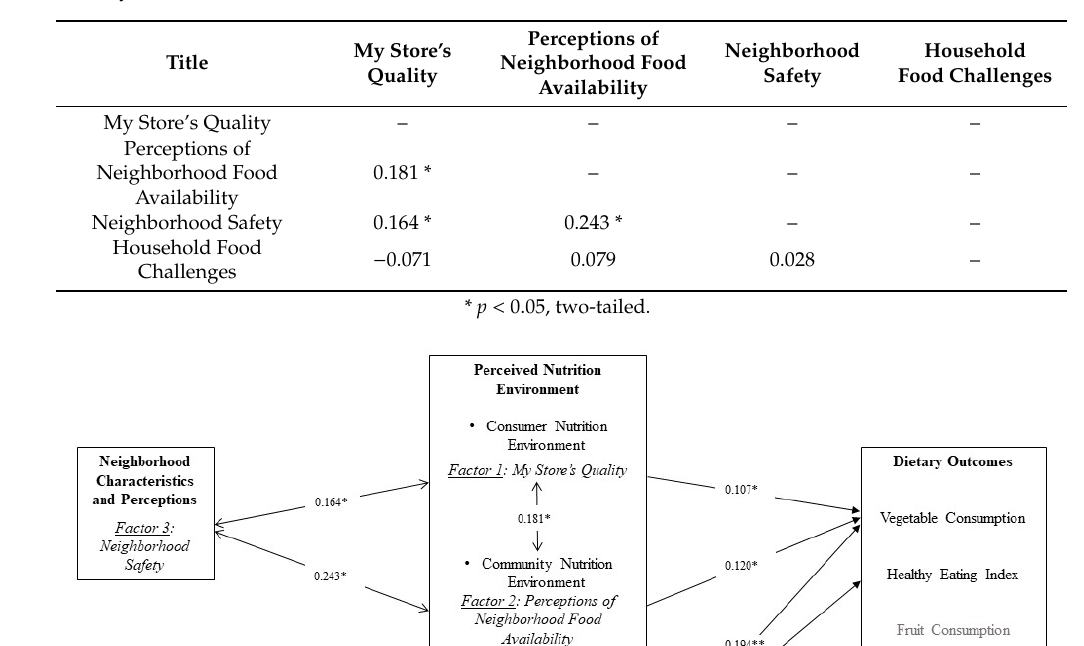
Table 4. Correlation Coe ffi cients for Factors Identified from Exploratory Factor Analysis of FIONS Survey Variables.